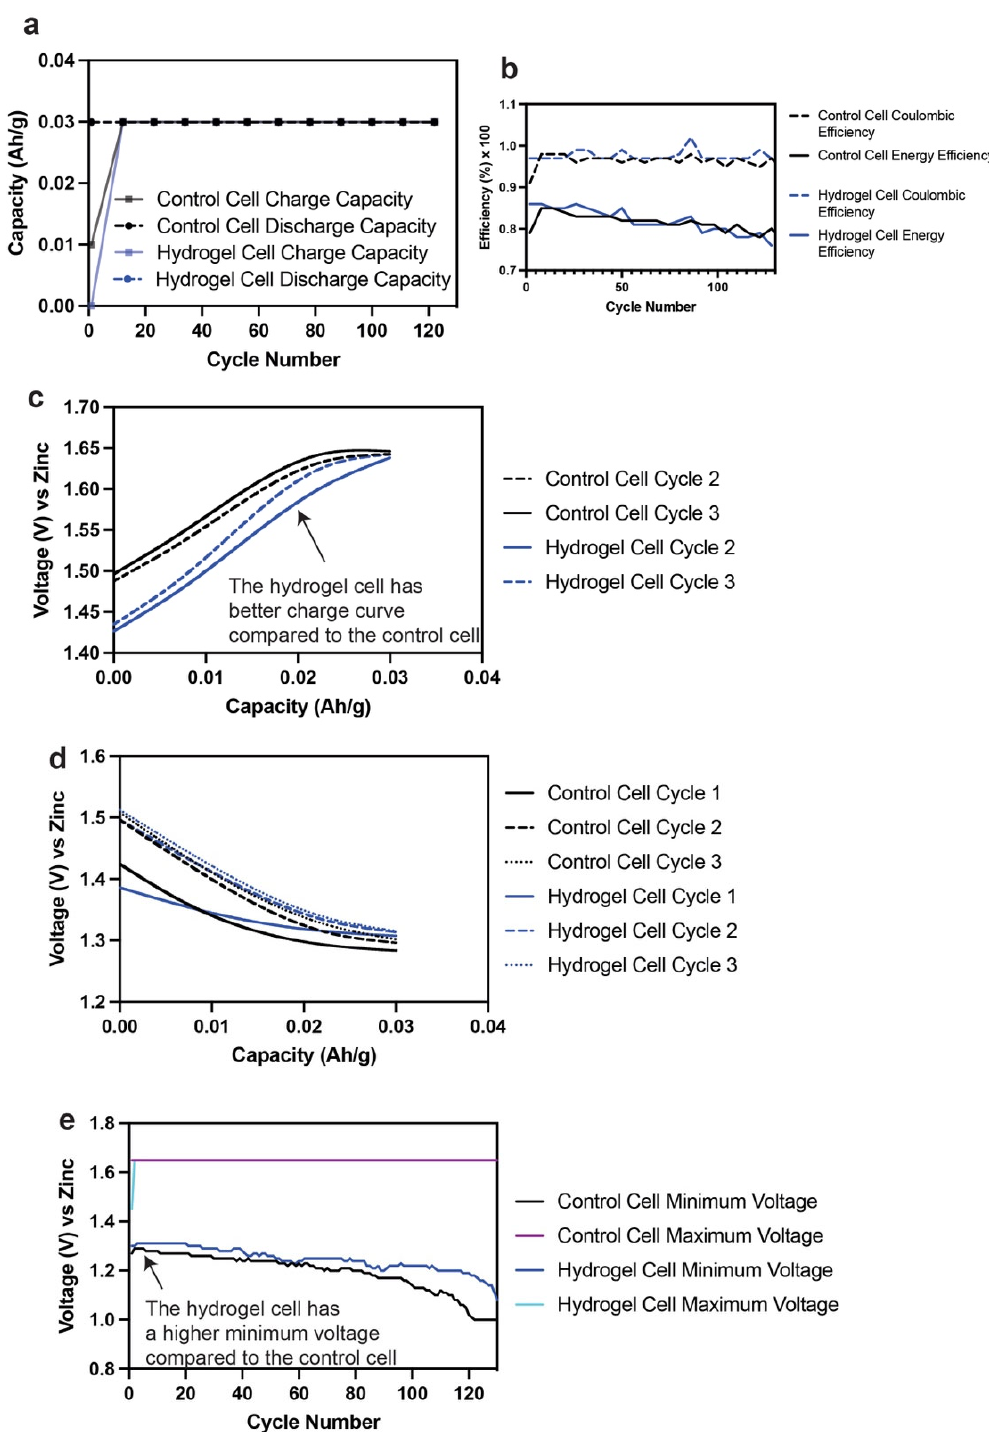
Figure 8. ( a ) Capacity retention comparison of a control (liquid) and hydrogel ‐ containing Zn–MnO 2 cell at 10% of MnO 2 1e − capacity. ( b ) Coulombic and energy efficiency comparison of a control (liquid) and hydrogel ‐ containing Zn–MnO 2 cell at 10% of MnO 2 1e − capacity. ( c ) Charge curves for cycles 2 and 3 of a control (liquid) and hydrogel ‐ containing Zn–MnO 2 cell at 10% of MnO 2 1e − capacity. ( d ) Discharge curves for cycles 1, 2 and 3 of a control (liquid) and hydrogel ‐ containing Zn–MnO 2 cell at 10% of MnO 2 1e − capacity. ( e ) Maximum and minimum voltage comparison of a control (liquid) and hydrogel ‐ containing Zn–MnO 2 cell at 10% of MnO 2 1e − capacity.